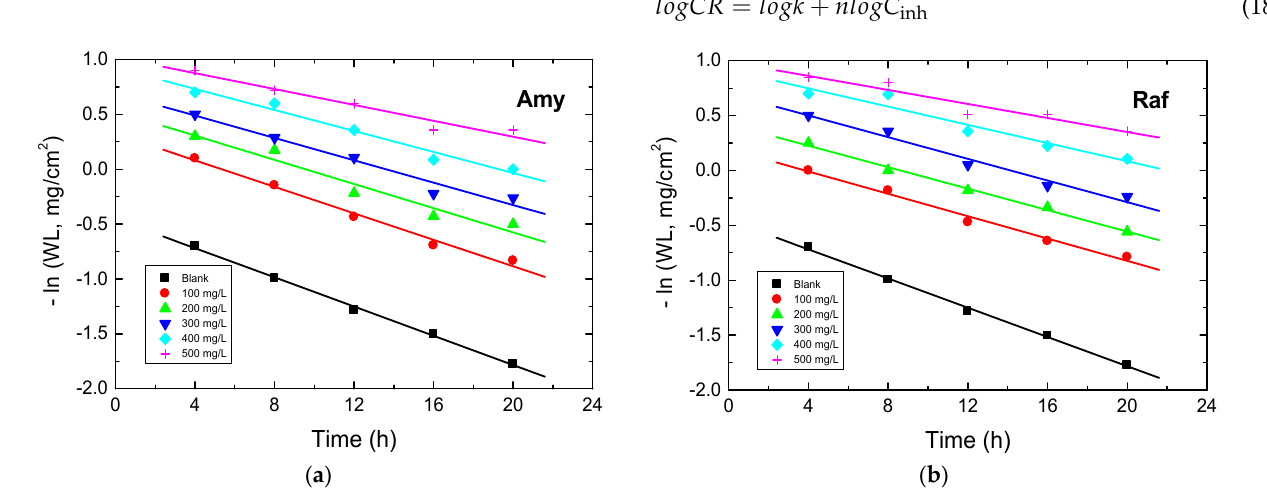
Figure 13. First ‐ order plots for Al corrosion in 0.1 M NaOH medium and with, ( a ) Amygdalin Figure 13. First-order plots for Al corrosion in 0.1 M NaOH medium and with, ( a ) Amygdalin (Amy), (Amy), and ( b ) Raffinose (Raf) at 298 K. and ( b ) Raffinose (Raf) at 298 K. Table 7. Values of k 1 and t 1/2 (half-life time) for Al corrosion in 0.1 M NaOH medium and with Amy Table 7. Values of k 1 and t 1/2 (half ‐ life time) for Al corrosion in 0.1 M NaOH medium and with Amy and Raf at 298 K. and Raf at 298 K. Inhibitor Conc.